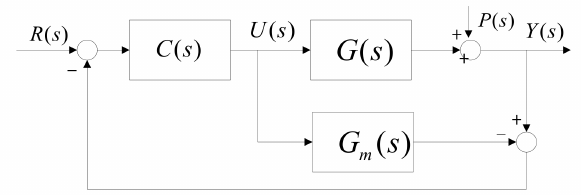
Figure 1. Basic structure of the multivariate internal model